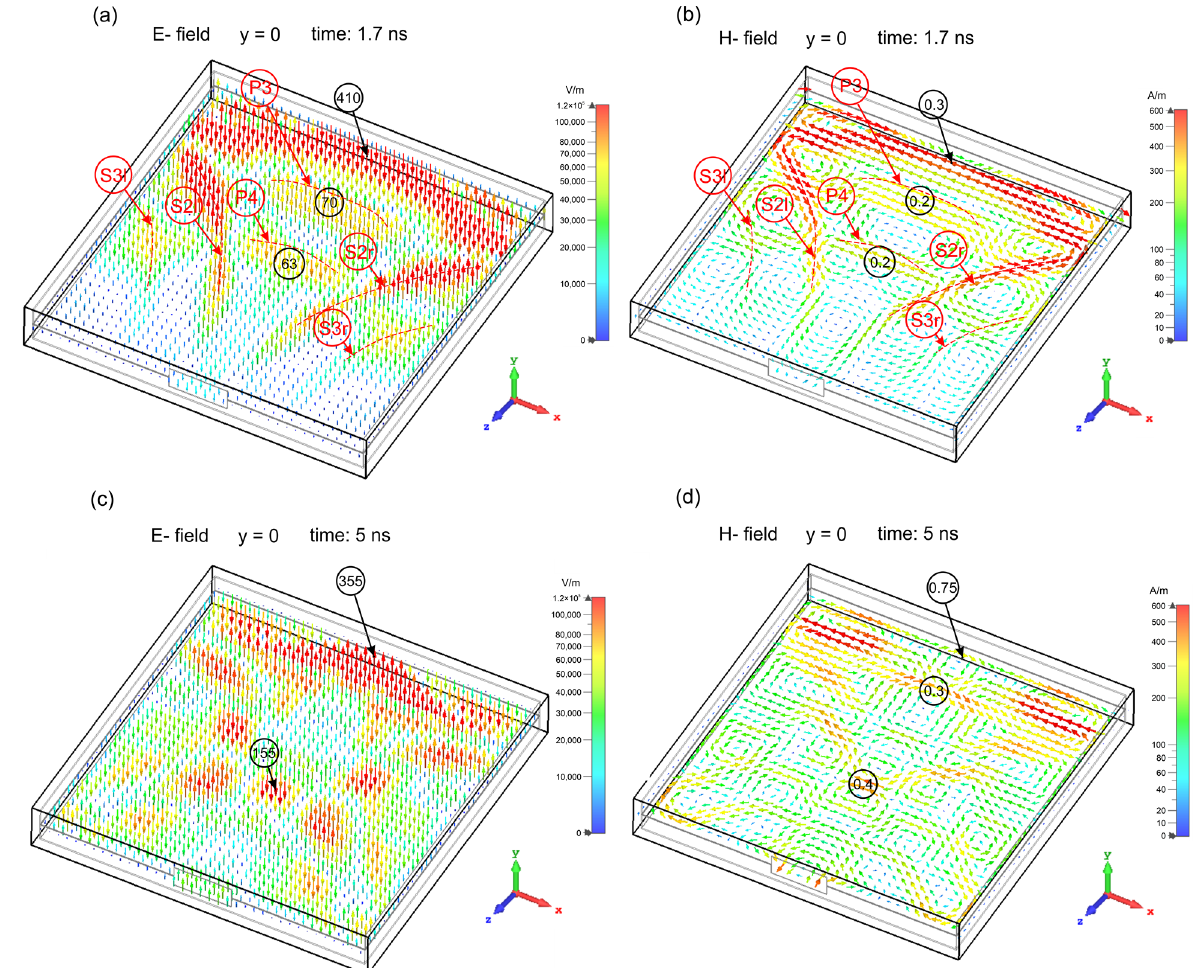
Figure 6. 2D vector maps illustrating development of the electric and magnetic fields in the enclosure in the interference phase at various times. Left column —the electric field amplitude, right column —the magnetic field amplitude. The amplitudes of the electric field in 10 3 V/m and magnetic field at 10 3 A/m are given in circles. P3 and P4—the primary waves, S2l and S3l—the secondary waves formed at the left side of the enclosure; S2r and S3r—the secondary waves formed at the right side of the enclosure. ( a , b ) and ( c , d ) show the electric and magnetic fields at times t = 0.96 ns and t = 1.5 ns, respectively.